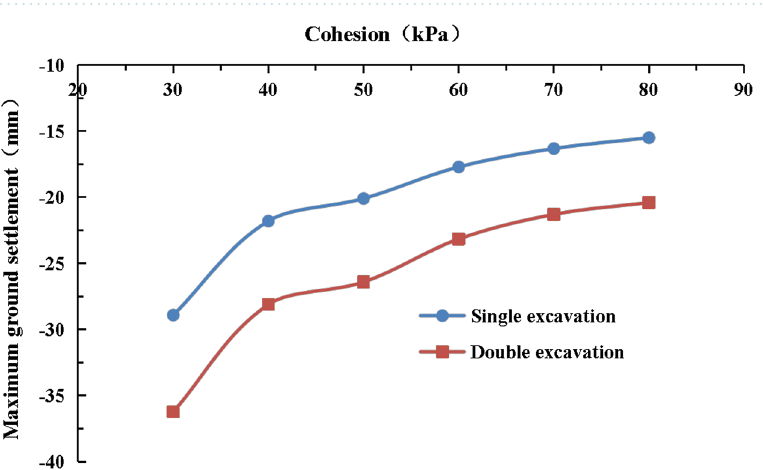
Figure 21. The maximum surface settlement during single-line and double-line excavation for different cohesion